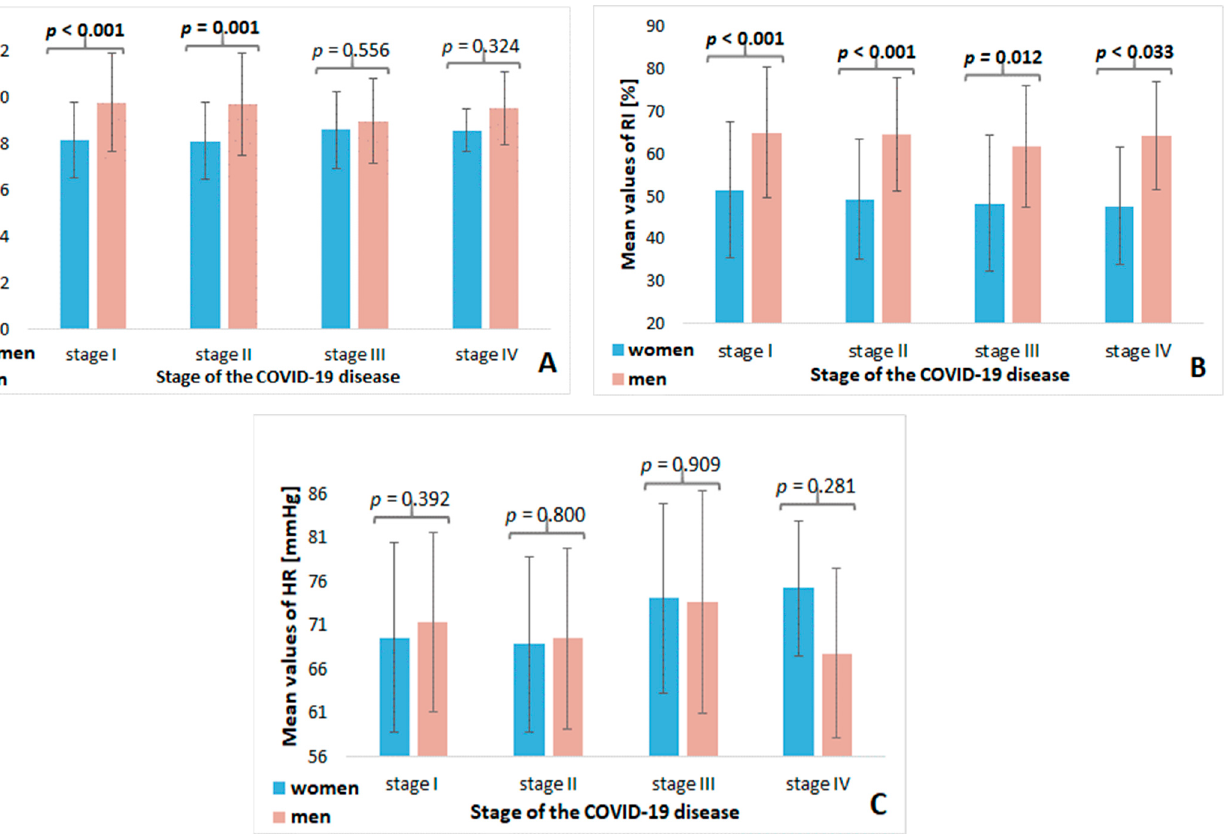
Figure 1. Differences in the parameters of SI, RI, and HR in the specific stages of acute COVID-19 based on sex (( A )—differences in SI parameter; ( B )—differences in RI parameter; ( C )—differences in HR). SI—stiffness index; RI—reflection index; HR—heart rate; Statistical differences are in bold.